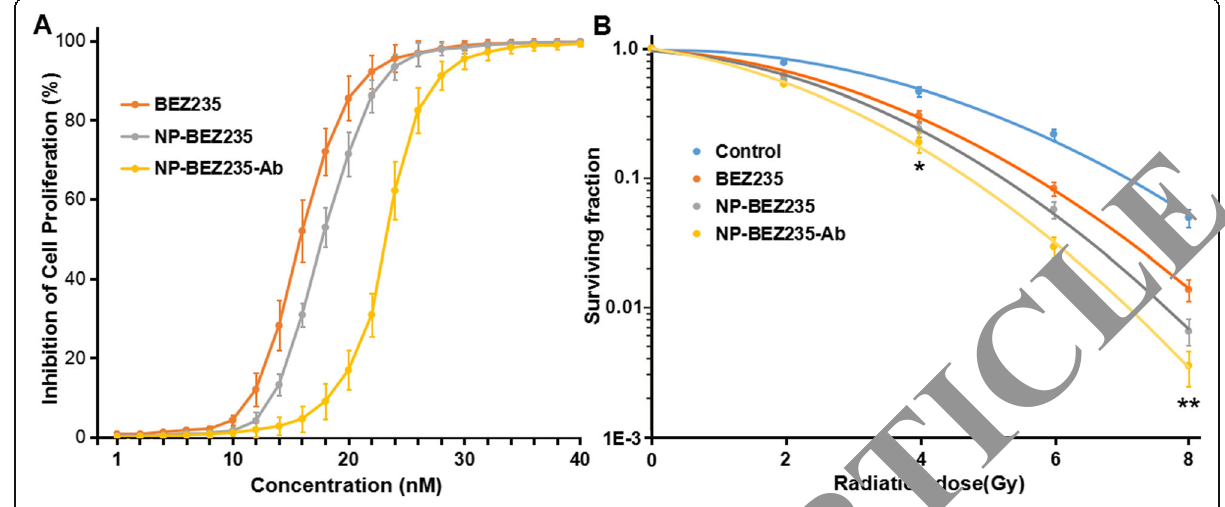
Fig. 4 Inhibition effects and survival curve of BEZ235 or BEZ235-loaded NPs administration. a Inhibition effects of BEZ235 or BEZ235-loaded NPs